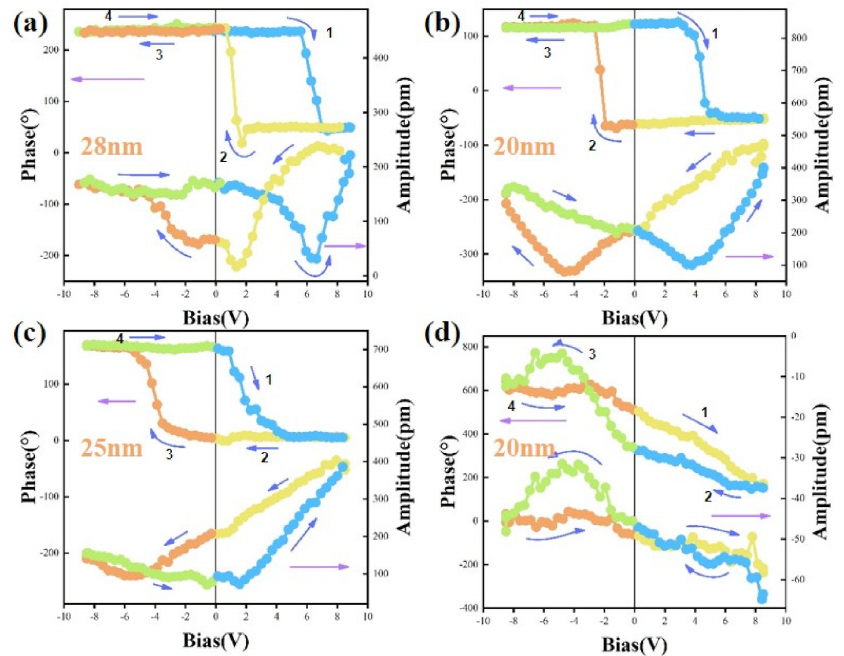
Figure 3. Ferroelectric polarization switching by PFM for CIPS flakes with different thicknesses. The PFM amplitude (green) and phase (blue) hysteresis loops during the switching process for CIPS flakes with thickness of ( a ) 28 nm, ( b ) 20 nm, ( c ) 25 nm, and ( d ) another area of the sample with the thickness of 20 nm.